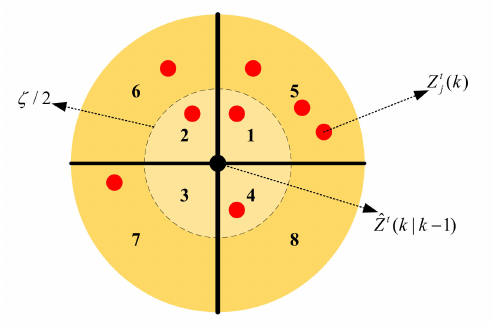
Figure 2. The tracking gate